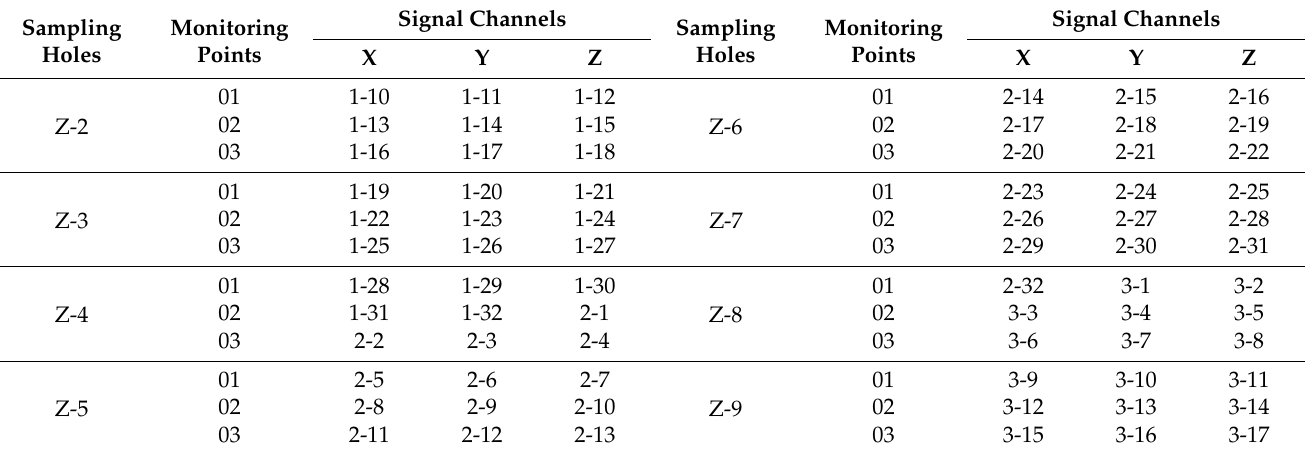
Table 2. Signal channels corresponding to monitoring points.